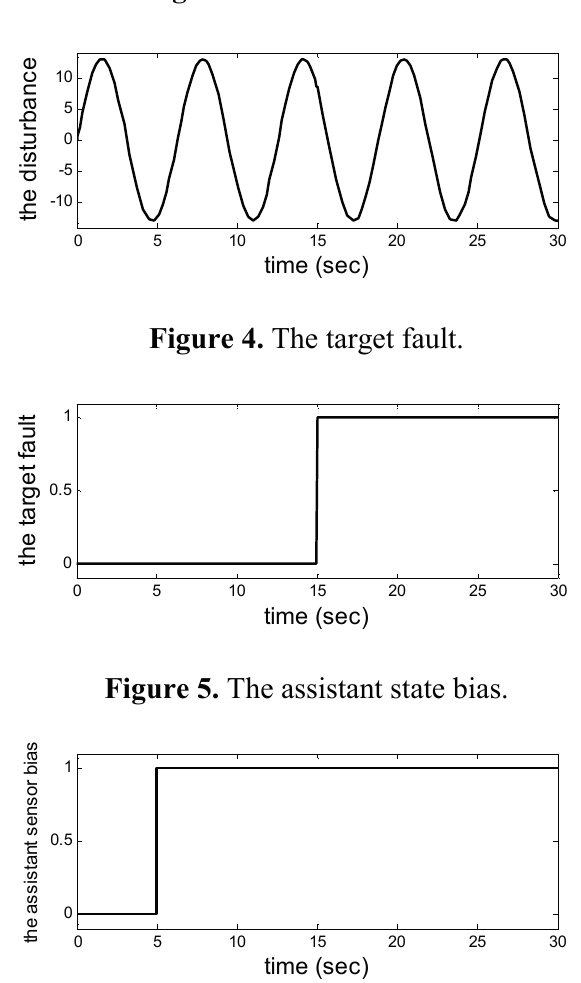
Figure 3. The disturbance.